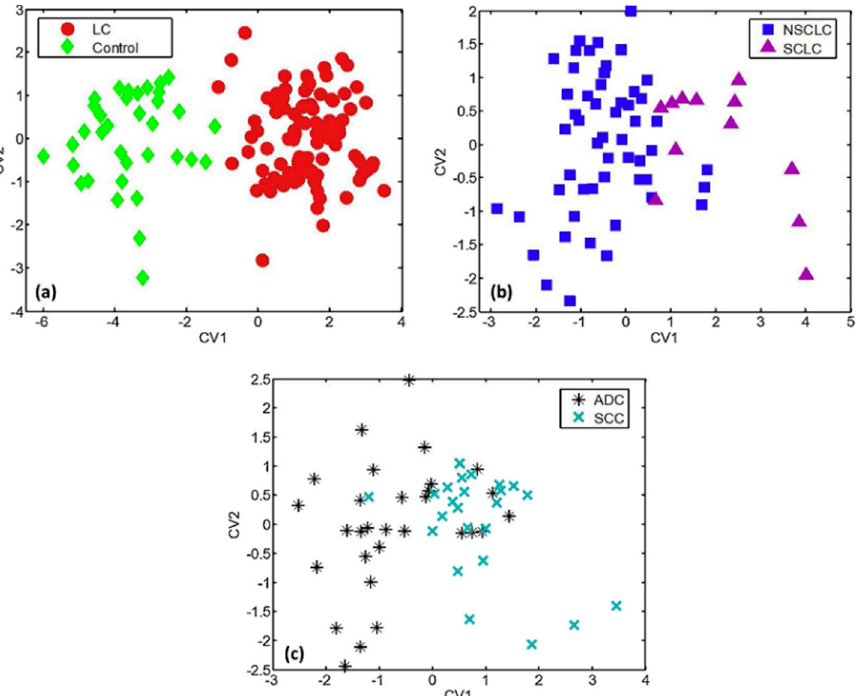
Figure 15. DFA plots representing the discrimination of ( a ) LC patients from HC; ( b ) SCLC from NSCLC patients; and ( c ) SCC from ADC patients, using a 6-sensor array of UV-irradiated (394 nm) pristine or metal-doped WO 3 NWs. The arrays achieved the detection of lung cancer but also the prediction of LC histological subtypes. Reprinted with permission from Ref. [246]. Copyright © 2020 Published by Elsevier B.V.